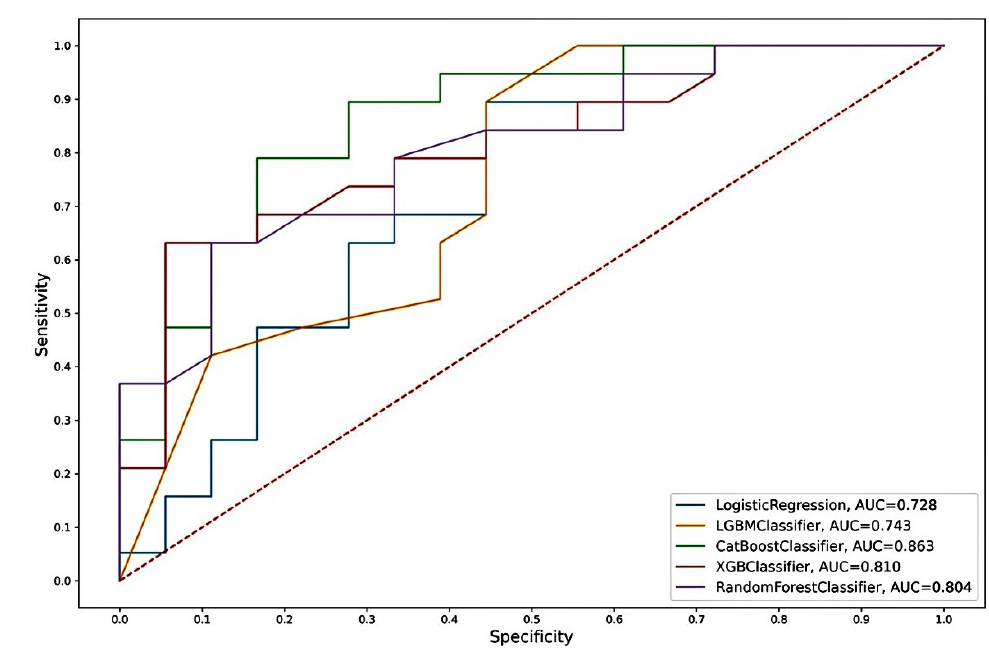
Figure 6. ROC curves of the “CST2 + OCLN + pT” model from Logistic Regression, LGBM, Catboost, Random Forest, and XGBoost algorithms.